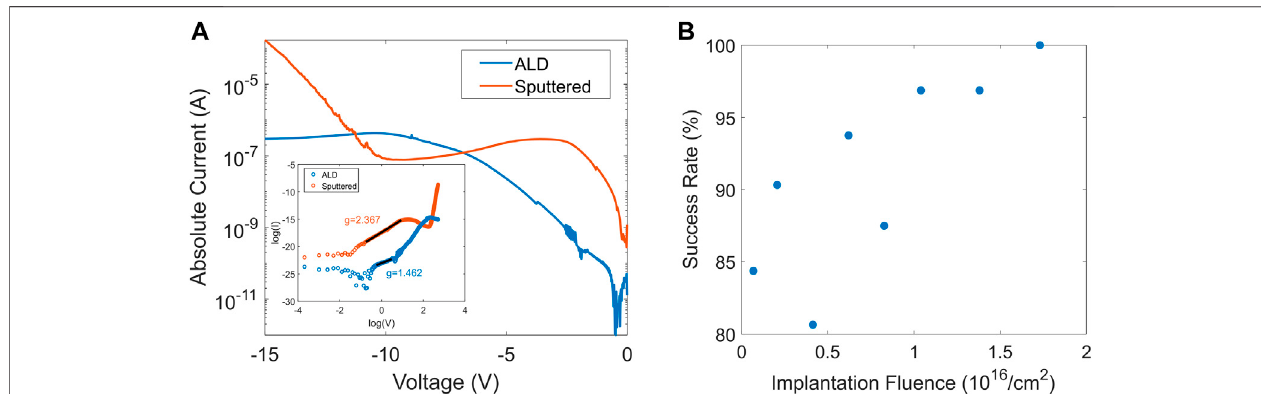
FIGURE 2 | (A) Electrical sweep of a pristine ALD-grown SiO x device and a pristine sputtered SiO x device. ALD-grown SiO x is less resistive due to lower concentrationofdefects.ChargetrappingorpolarizationcouldbethecauseofnegativedifferentialresistanceobservedinsputteredSiO x .InsetshowsSCLC fi ttingofthe two types of SiO x pristine states. In sputtered SiO x , SCLC is the dominating conduction mechanism before the negative differential resistance appears, supporting the hypothesis that negative differential resistance is caused by charge trapping. (B) Correlation between implantation fl uence and electroforming success rate when Ar + -implanted devices were swept to − 15 V, each data point includes 31 or 32 devices. As implantation fl uence increases, the electroforming success rate increases